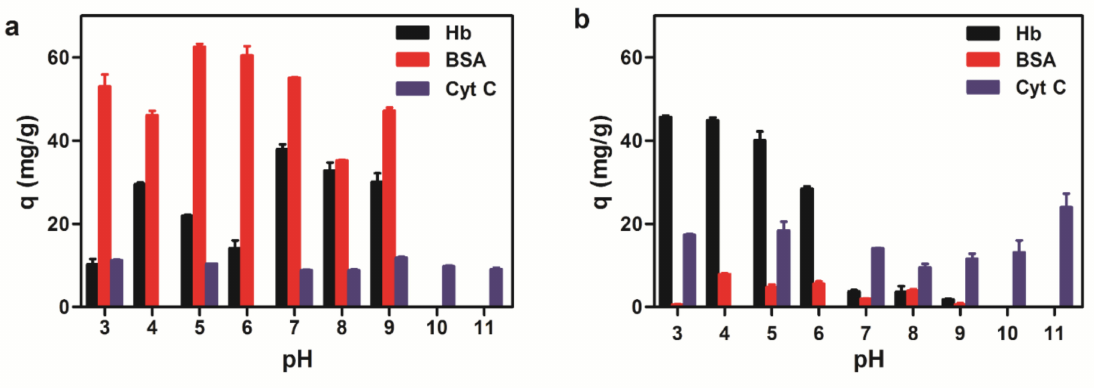
Figure 6. Adsorption capacity of three proteins to magnetic microspheres with different pH values. ( a ) Amino magnetic microspheres. ( b ) Carboxyl magnetic microspheres. The carboxyl magnetic microsphere was negatively charged on the protein surface.